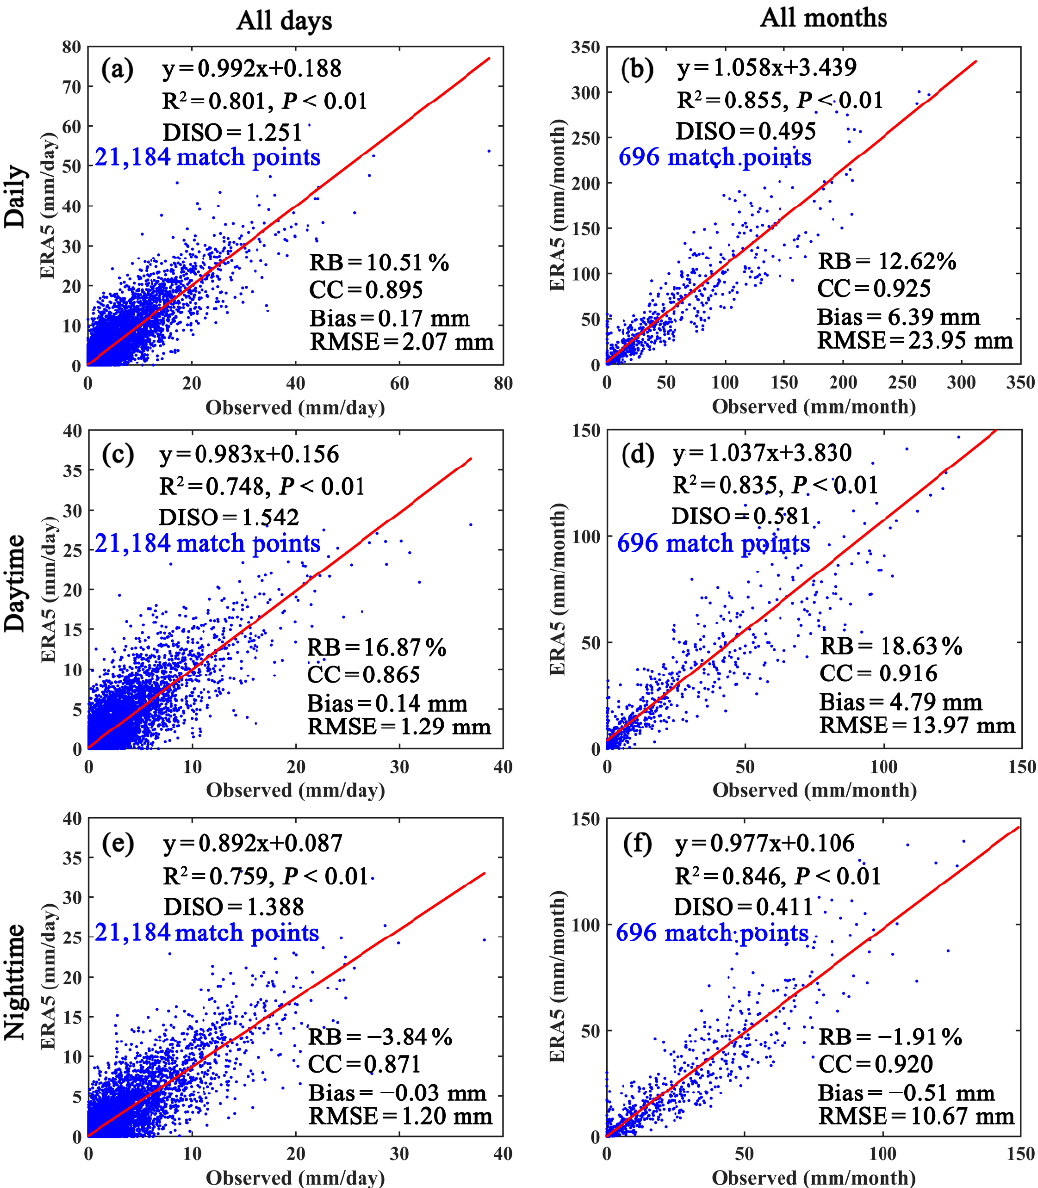
Figure 3. Scatterplot of daily ( a , b ), daytime ( c , d ), and nighttime ( e , f ) extreme precipitation from surface observational stations and their corresponding ERA5 grid points in the YRD for the period 1961–2018. The left (right) column represents all-day (all-month) values, and solid red lines denote linear regression lines. The 21,184 and 696 matching points on the all-day and all-month scales represent the temporal comparisons over 21 and 184 days and 696 months, respectively.